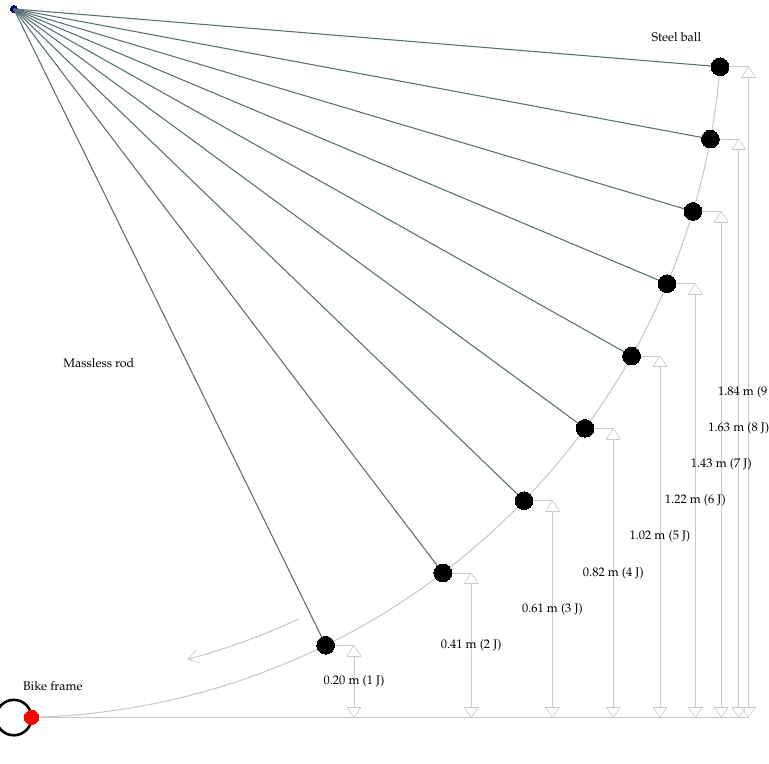
Figure 3. Procedure used to generate impact damage.